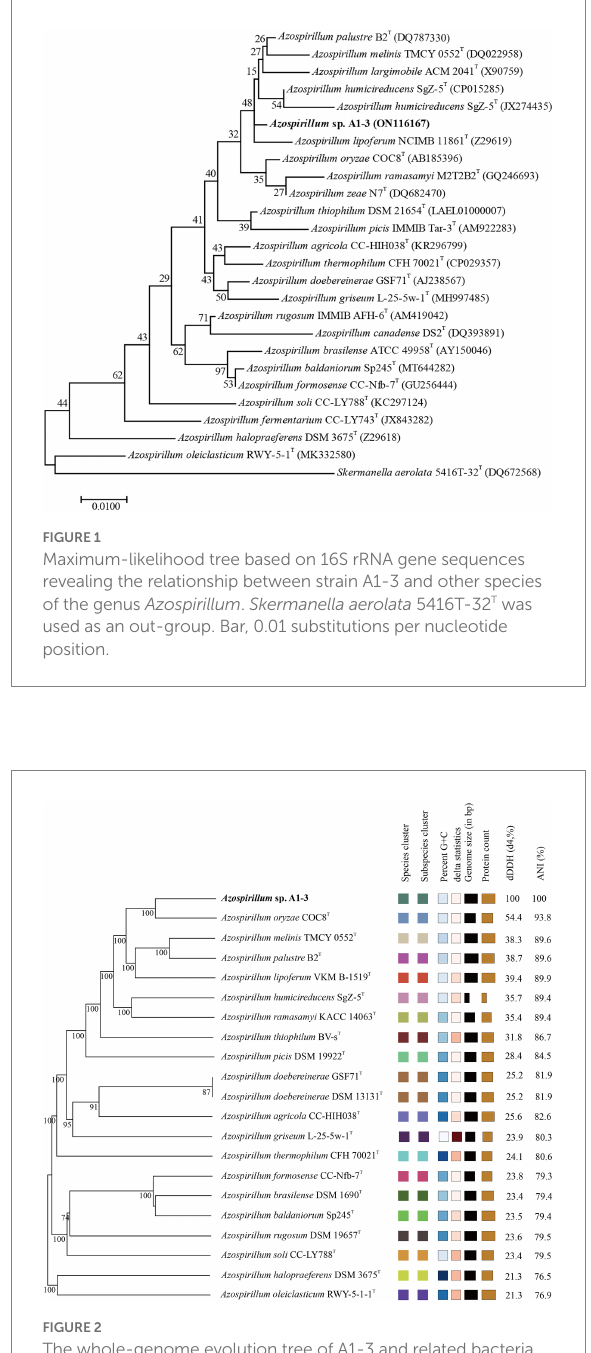
platform. The draft genome of Azospirillum sp. A1-3 contained nine contigs with an N 50 /N 90 value of 795,522/606,539 bp. The genome